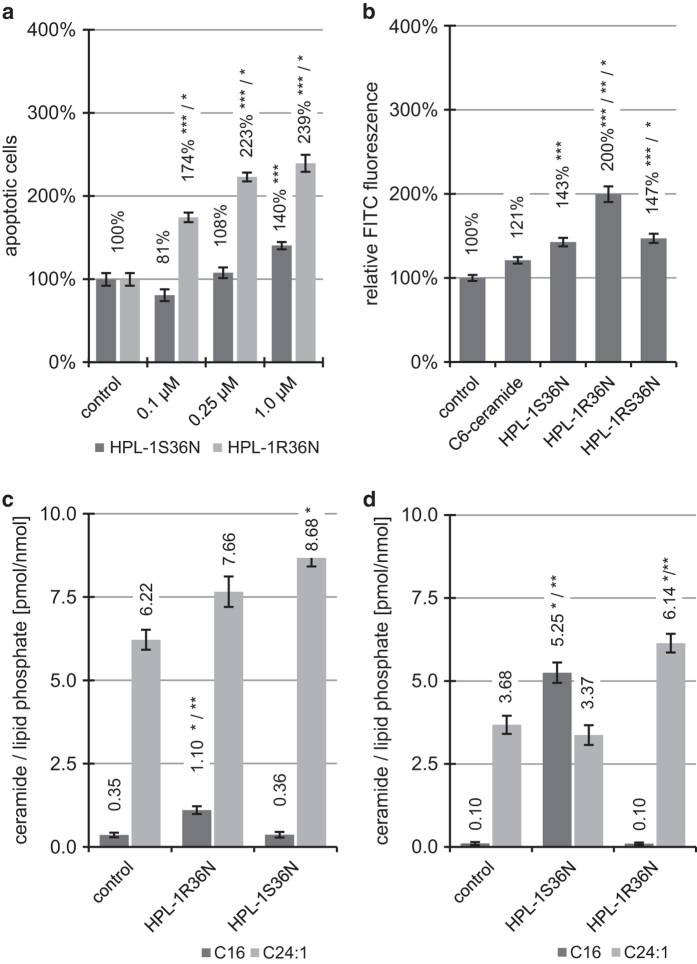
Diverging induction of apoptosis, caspase activity and ceramide concentrations of synthetic ceramide analogs in macrophages. (a) Macrophages were treated 4 h with 0.1, 0.25 and 1.0 μM HPL-1R36N (6) or HPL-1S36N (7) and stained using YO-PRO-1 iodide (apoptotic cells) and Hoechst 33342 (complete cells). (b) Caspase activity (in situ-activated caspases labeled with CaspACE-FITC-VAD-FMK) in isolated monocytes treated 16 h with 10 μM HPL-1RS36N (8), HPL-1R36N (6), HPL-1S36N (7) and exogenous C6-ceramide (1) as positive control. Data shown as mean±S.E., n=3. One-way ANOVA in combination with post hoc t-tests and Bonferroni's correction for multiple testing, P<0.0001 (one-way ANOVA); significantly different with P<0.05: *** versus control (a and b), ** versus HPL-1RS36N (8) (a),* versus HPL-1S36N (7) (a) or exogenous C6-ceramide (1) (b). (c) Macrophages were treated 4 h and (d) 7 h with 10 μM HPL-1R36N (6) and HPL-1S36N (7), C16- and C24:1-ceramide concentrations shown as mean±S.E., n=3. One-way ANOVA in combination with post hoc t-tests and Bonferroni's correction for multiple testing, P<0.0001 (one-way ANOVA); significant with P<0.05: * versus control, ** versus HPL-1S36N (7).